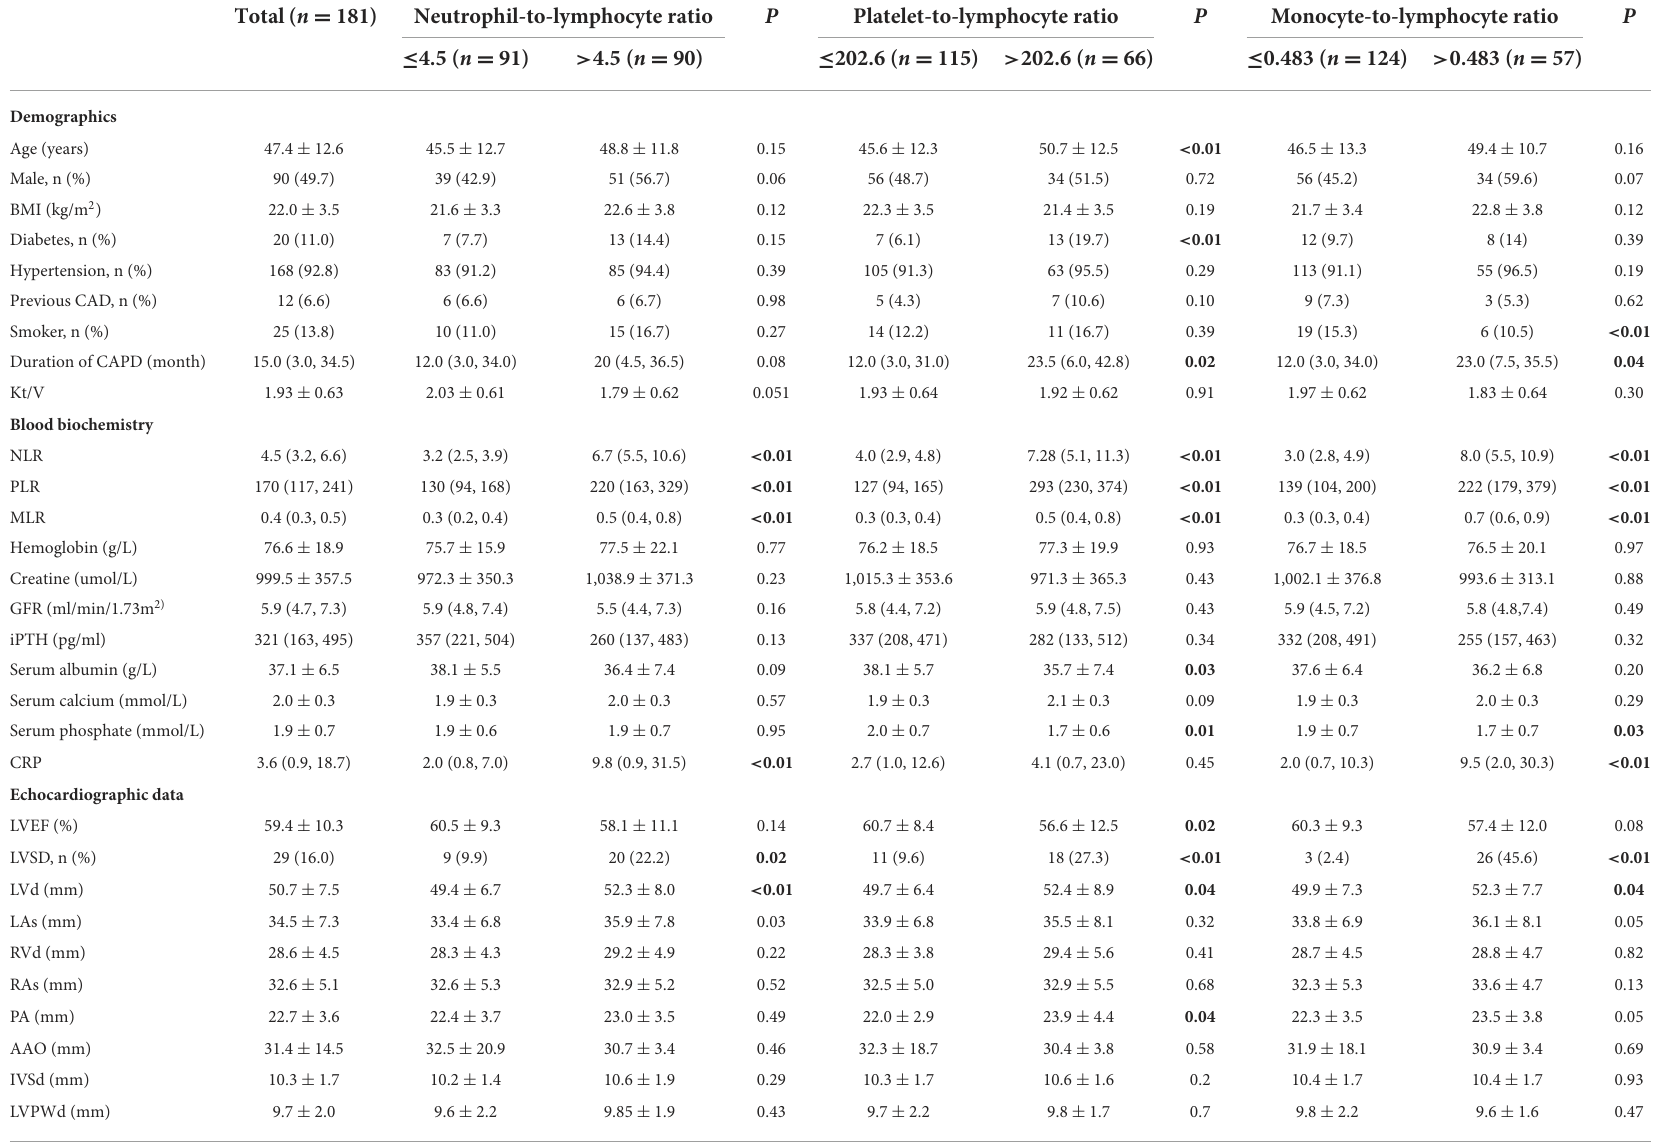
TABLE 1 Basic information of demographic, laboratory and echocardiographic characteristics in peritoneal dialysis patients. Total ( n = 181) Neutrophil-to-lymphocyte ratio P Platelet-to-lymphocyte